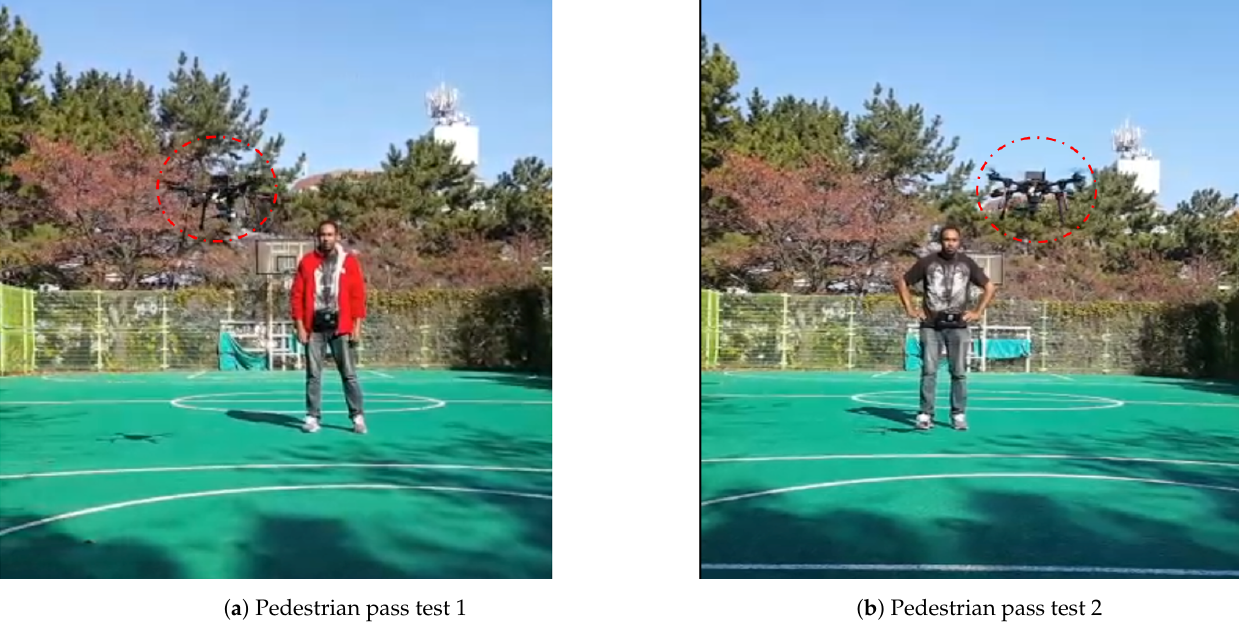
Figure 11. Pedestrian as obstacle pass tests.